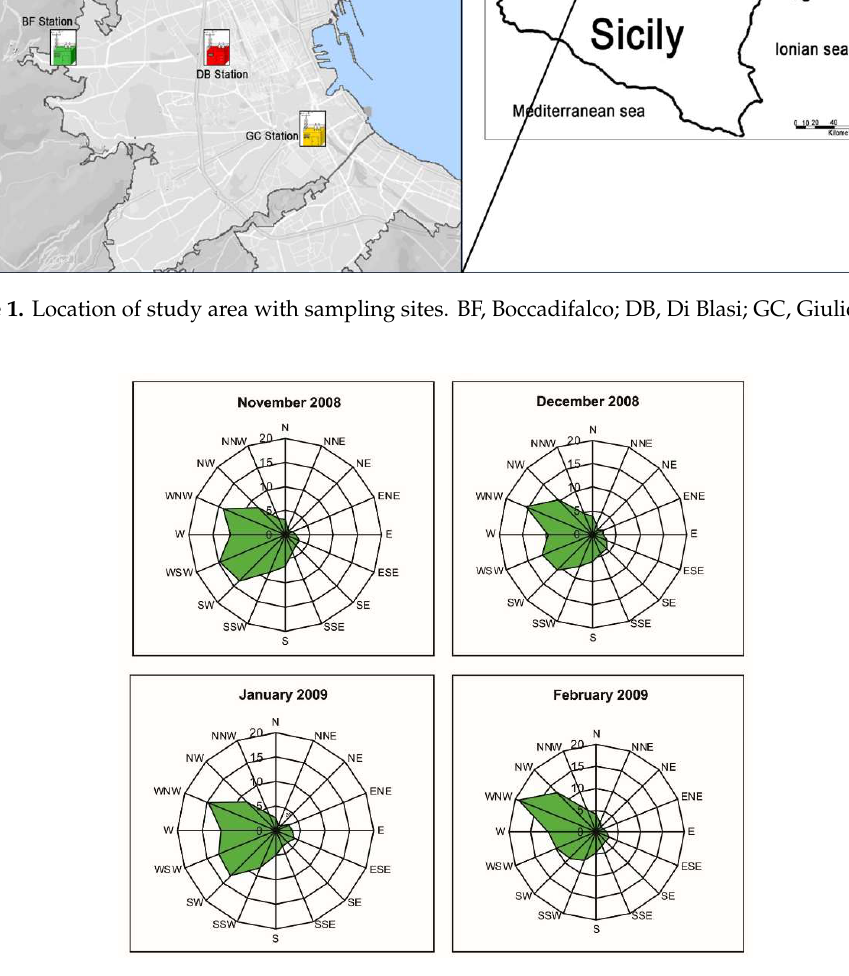
Figure 2. Prevailing winds at Palermo during the sampling period.